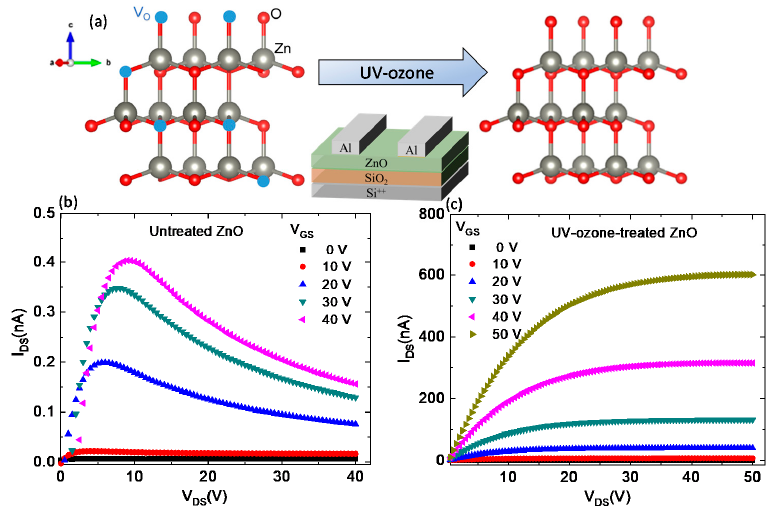
Figure 3. ( a ) A schematic representation of the ZnO structure where the oxygen vacancies (blue circles) are filled upon UV–ozone-treatment. The inset shows the FET architecture. ( b ) Output characteristics of an untreated ZnO FET. ( c ) Output characteristics of a UV–ozone-treated ZnO